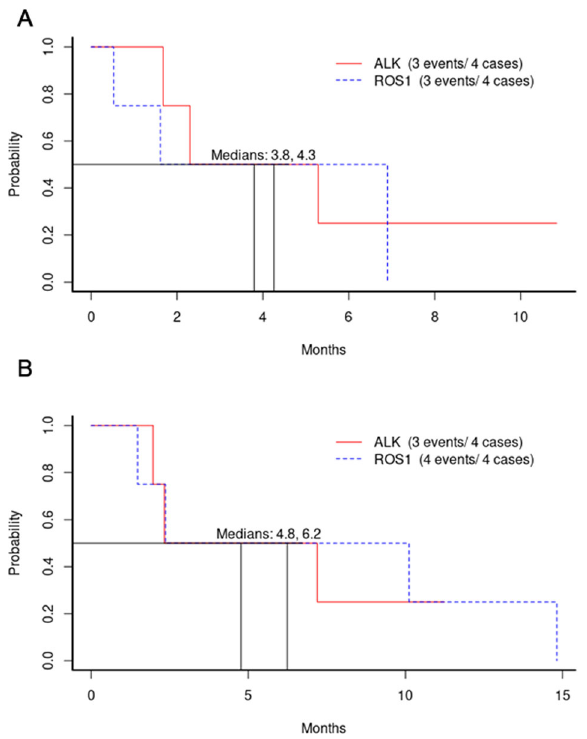
Fig. 2 Progression-free and overall survival for both sub- protocols. The PFS A and OS B are presented for both ALK (EAY131-F) and ROS1 (EAY131-G)